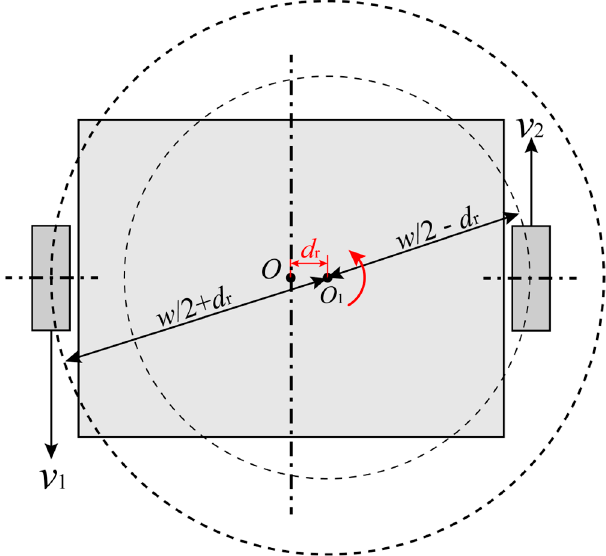
Figure 5. The rotation center lateral offset caused by the velocity difference. As the distances of the two wheels to the true center differ, the two wheels move along circularly with different radii. Suppose that the spacing between the wheels on two w sides is , then the radius of the left wheel trajectory is 2 w d + , and the radius of the r right wheel trajectory is 2 w d − . The angular velocities of the two wheels are the same. r